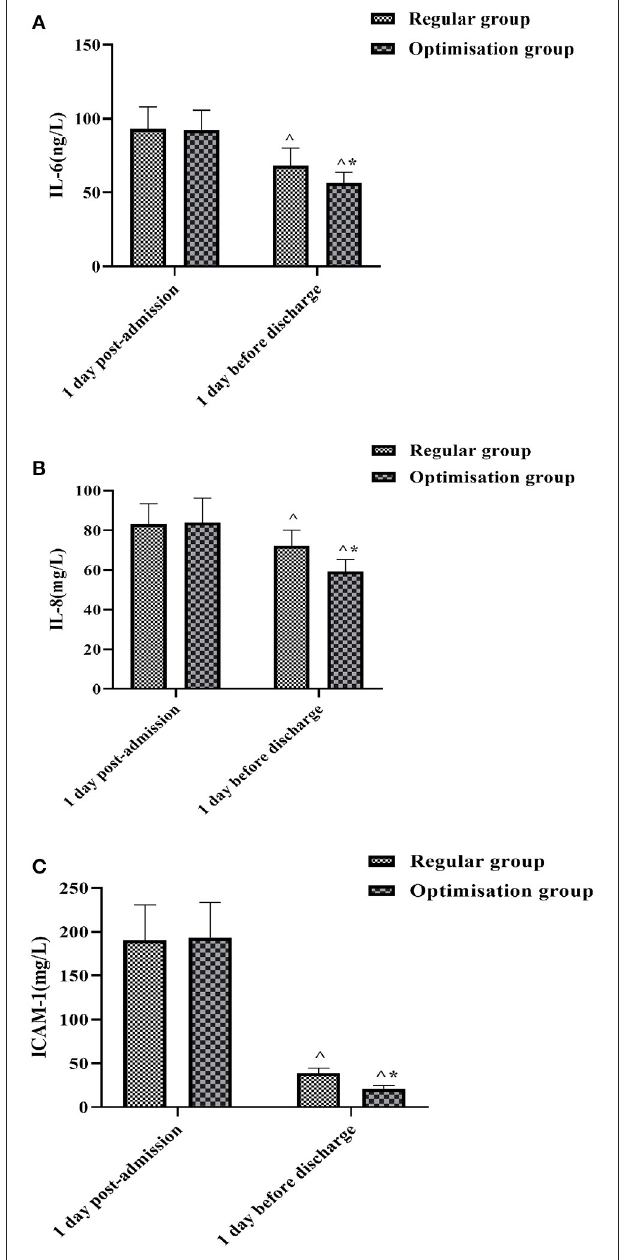
FIGURE 3 | Histogram comparing IL-6, IL-8, and ICAM-1 between the two groups at different times. (A) Shows the comparison of IL-6 levels. (B) Shows the comparison of IL-8 levels. (C) Shows the comparison of ICAM-1 levels. ∧ Denotes comparison with the same group 1 day post-admission, P < 0.05. *Denotes comparison with the regular group, P <